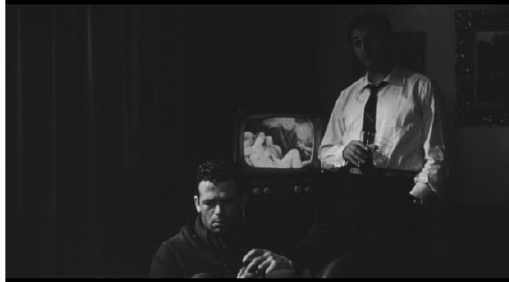
Figure 17 Screenshot from Rocco and His Brothers. (Goffredo Lombardo.)